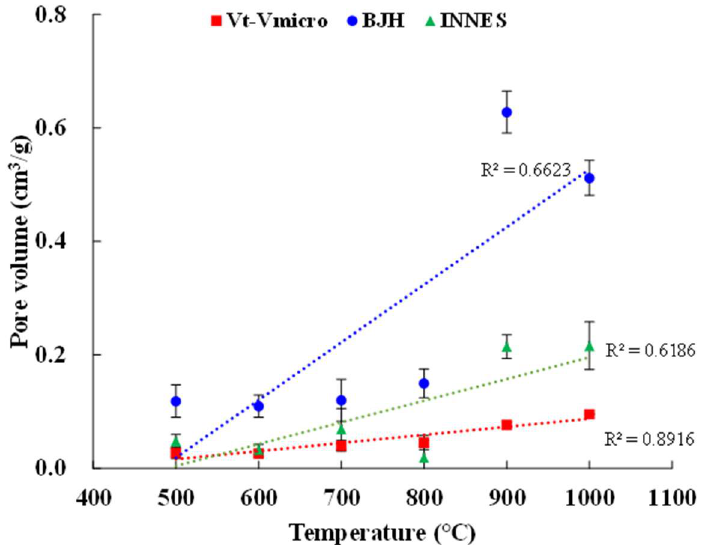
Figure 4. Correlation of activation temperature and mesopore volume evaluated by three meth- ods.